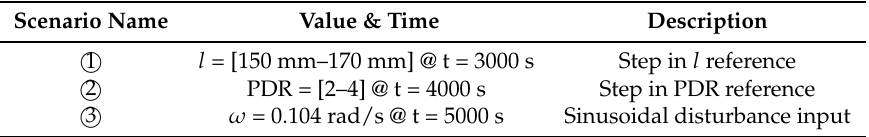
Table 3. Description of the simulation